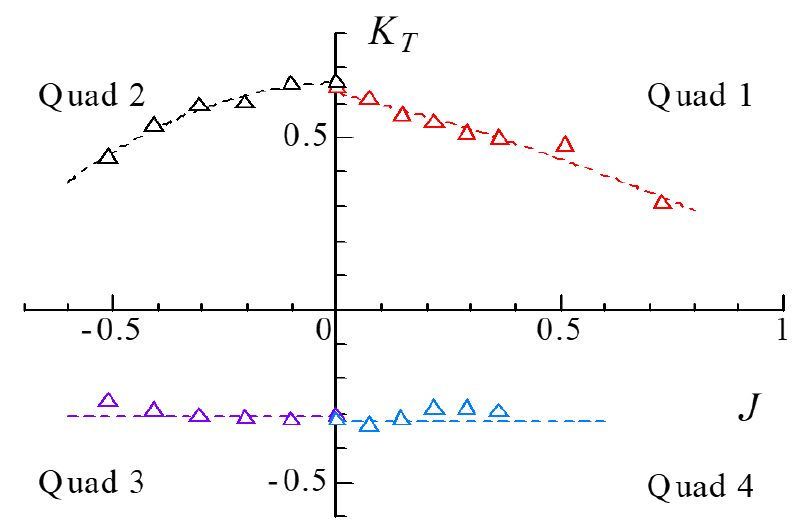
Figure 13. K T of four quadrants.